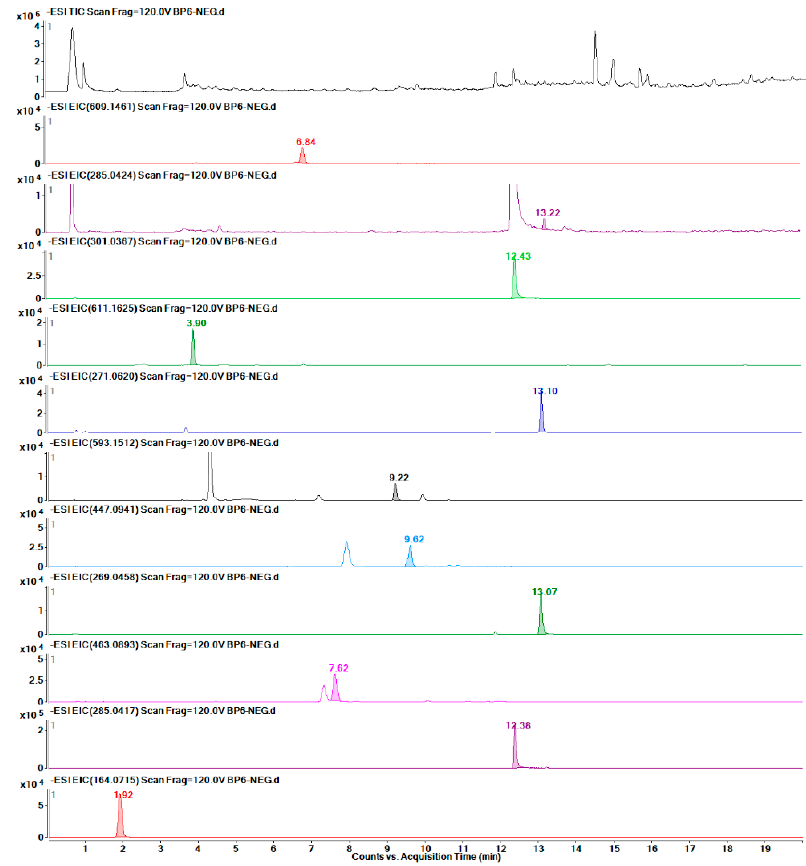
Figure 10. TIC of the BP part and EICs of each of the eleven metabolites.